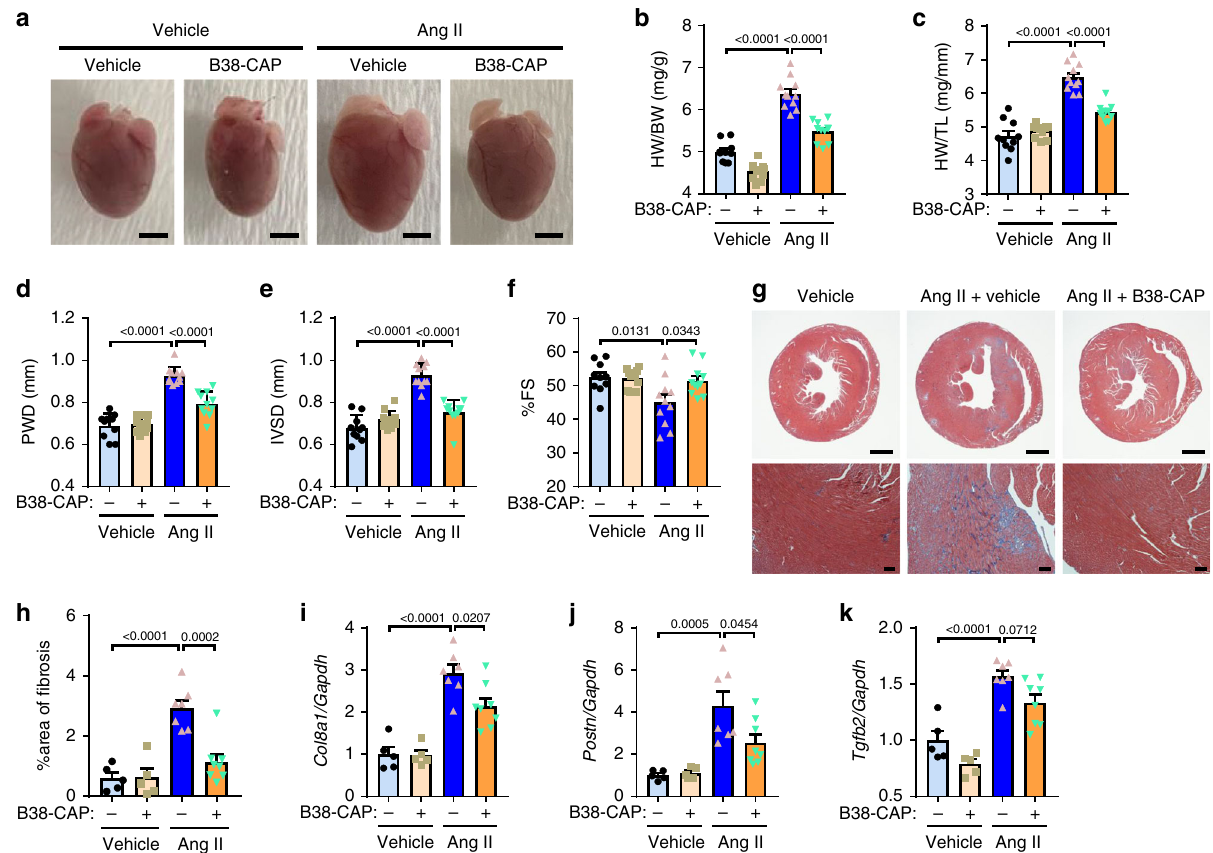
Fig. 3 Effects of B38-CAP on angioteinsin II-induced cardiac hypertrophy and fi brosis. a – c Cardiac hypertrophy in the mice chronically co-treated with Ang II (1.5 mg kg − 1 per day) and B38-CAP (3 mg kg − 1 per day) in the cohort of Fig. 2d – h. Macroscopic heart images ( a ), heart weight to body weight ratio (HW/BW) ( b ), and heart weight to tibia length ratio (HW/TL) ( c ) in mice treated vehicle + vehicle ( n = 10), vehicle + B38-CAP ( n = 11), Ang II + vehicle ( n = 11), and Ang II + B38-CAP ( n = 11). Bars indicate 2 mm. d – f Echocardiography parameters of left ventricular end-diastolic posterior wall thickness (PWD) ( d ), end-diastolic interventricular septal wall thickness (IVSD) ( e ), and %fractional shortening (%FS) ( f ) in the mouse hearts. Complete echocardiography data are shown in Supplementary Table 2. g , h Histology of hearts. Masson ’ s trichrome staining ( g ); bars indicate 2 mm and 100 μ m in the upper panels and lower panels, respectively. Quanti fi cation of fi brosis in the hearts ( h ) of mice treated with vehicle + vehicle ( n = 5), vehicle + B38- CAP ( n = 5), Ang II + vehicle ( n = 7), and Ang II + B38-CAP ( n = 8). i – k qRT-PCR analysis of pro- fi brotic gene expressions in the hearts of mice treated with vehicle + vehicle ( n = 5), vehicle + B38-CAP ( n = 5), Ang II + vehicle ( n = 7), and Ang II + B38-CAP ( n = 8); mRNA levels of Collagen 8a ( Col8a1 ) ( f ), Periostin ( Postn ) ( g ), and TGF- β ( Tgfb2 ) ( h ) normalized with Gapdh . All values are means ± SEM. b – f , h – k Two-way ANOVA with Sidak ’ s multiple- comparisons test. Numbers above square brackets show signi fi cant P